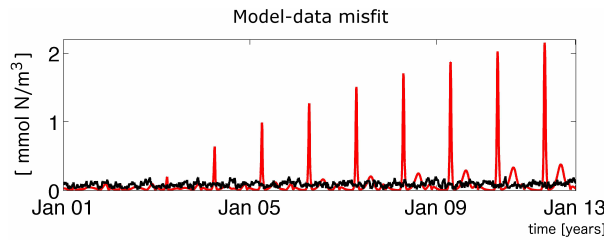
Figure 3. Temporal evolution of the difference between the genuine truth and the first ensemble member of the level 1 NOISE experi- ment (measured by the model–data misfit; Eq. 9). The black (red) line refers to simulations driven by forcing OPTI